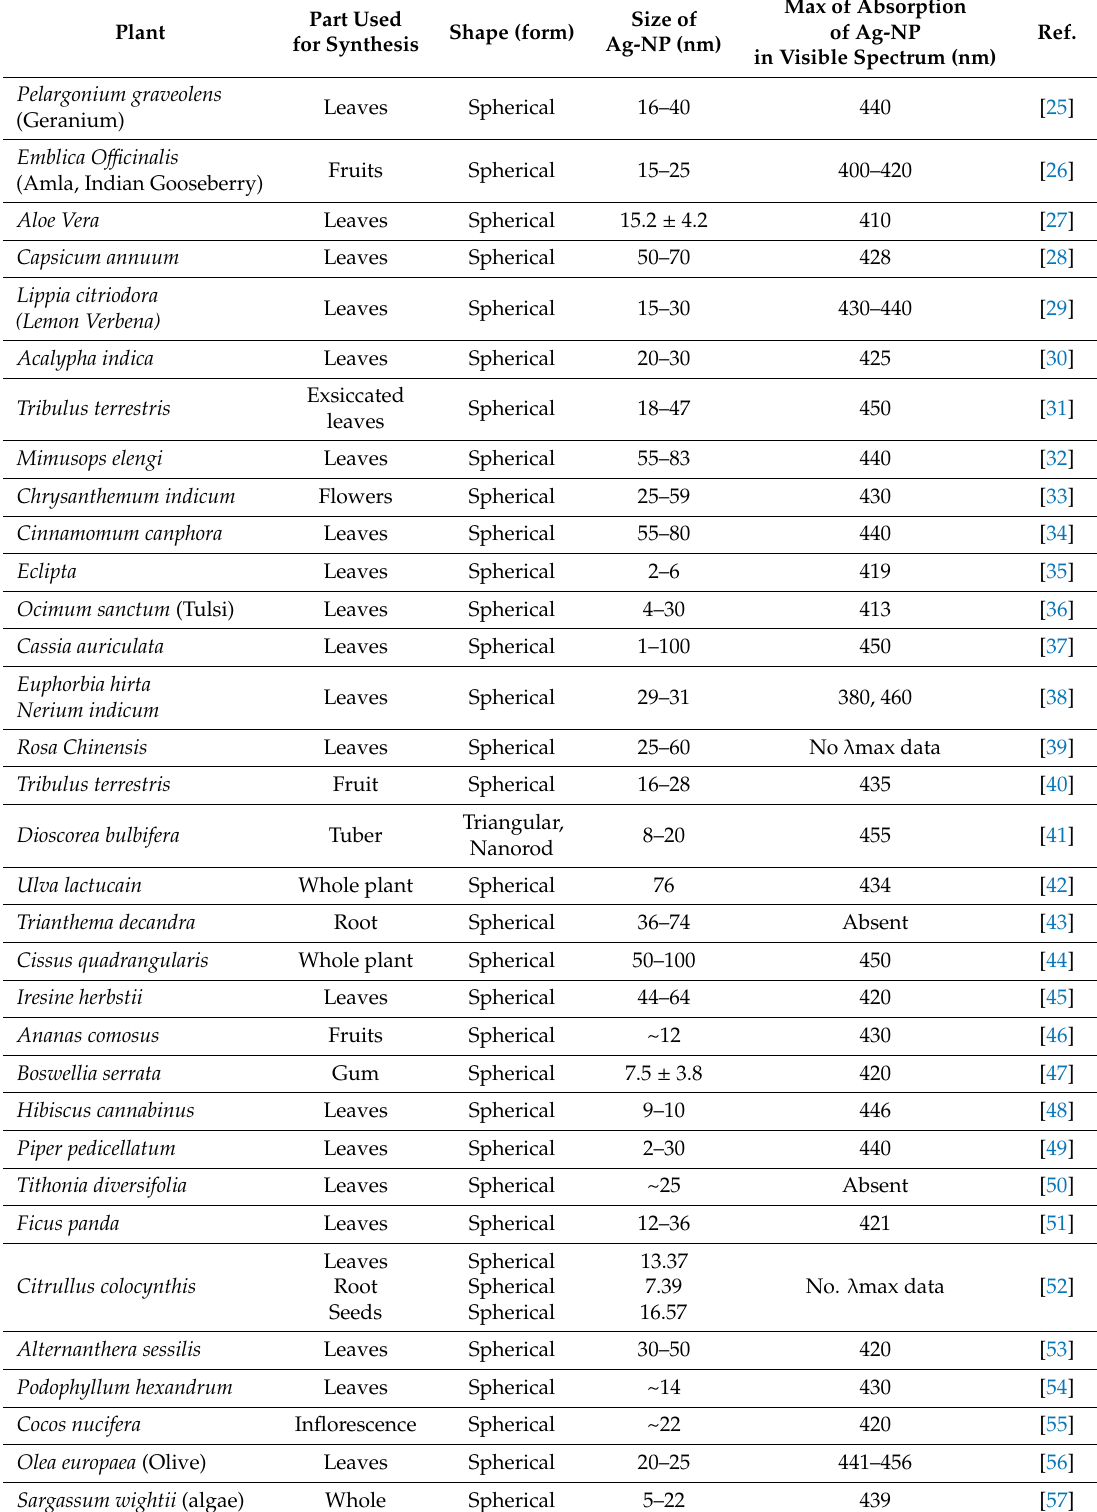
Table 1. Sizes and shapes of Ag-NP obtained by “green synthesis” using plant extracts.